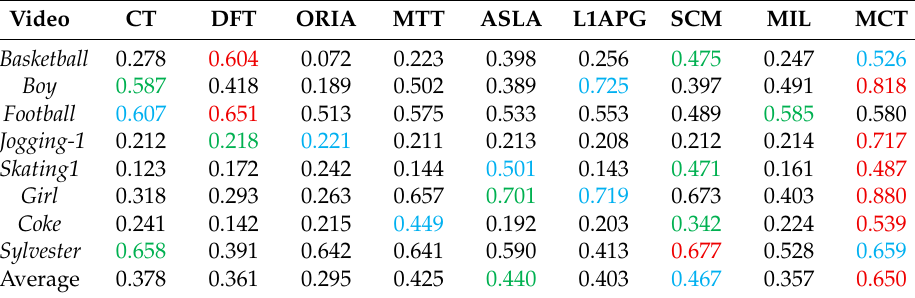
Table 5. Average success rate of the algorithms.